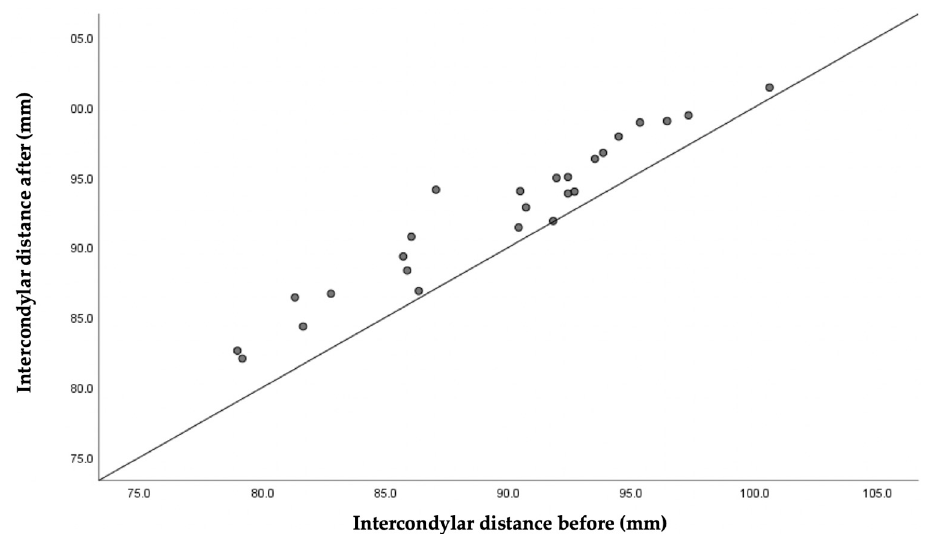
Figure 3. Relationship between the intercondylar distance before and after expansion. The iota coefficient for the agreement was equal to 0.885, showing a high intra-observer agreement. The Bland–Altman charts used to assess agreement are presented in Figure 4.